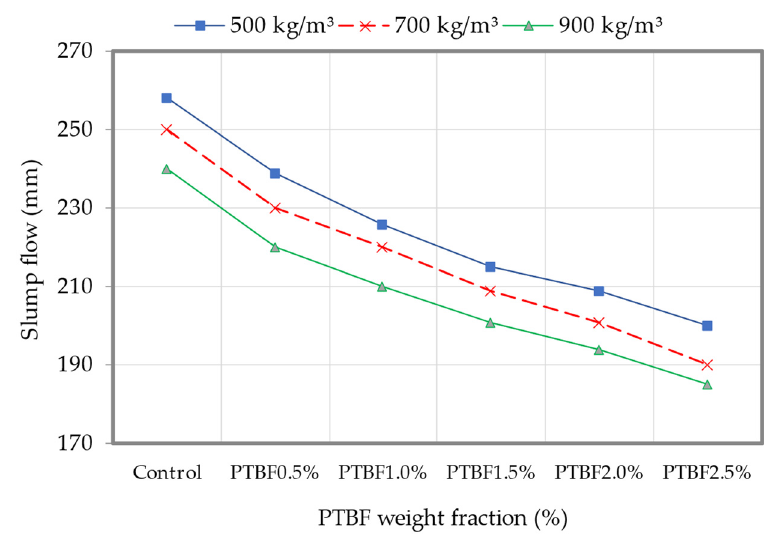
Figure 8. Slump flow of LFC with different weight fractions of PTBF.